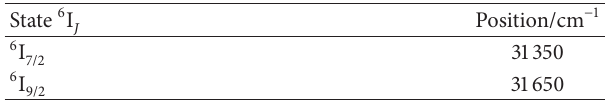
Table 3: Energetic positions of the Fano antiresonances in O :Eu 2+ SrAl 2 4